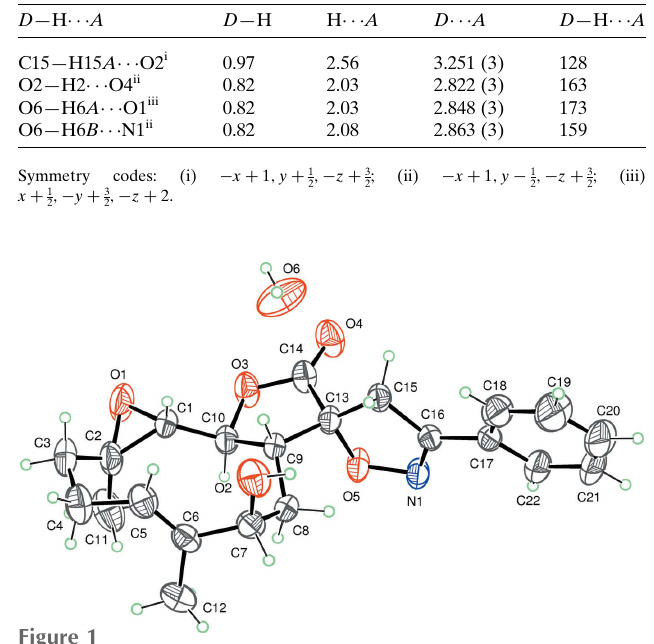
Table 1 Hydrogen-bond geometry (A˚ , (cid:3) ).